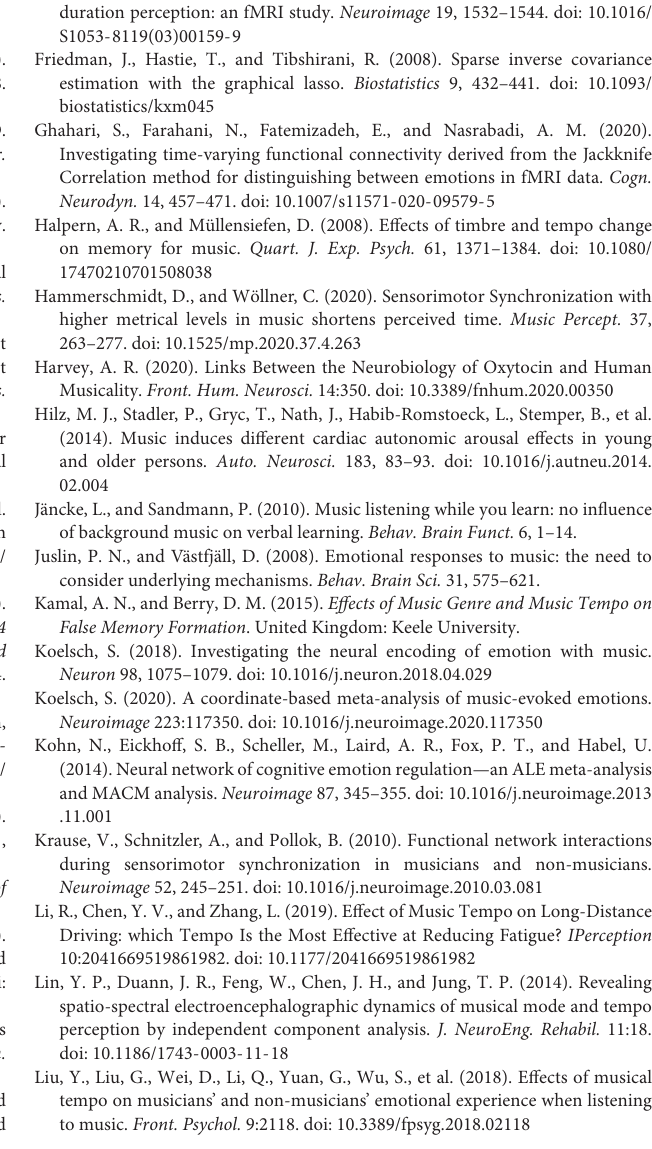
Supplementary Figure 1 | All subjects’ state transitions for the two kinds of music. Supplementary Table 1 | The details of the experiment music. Supplementary Table 2 | The coordinate information of